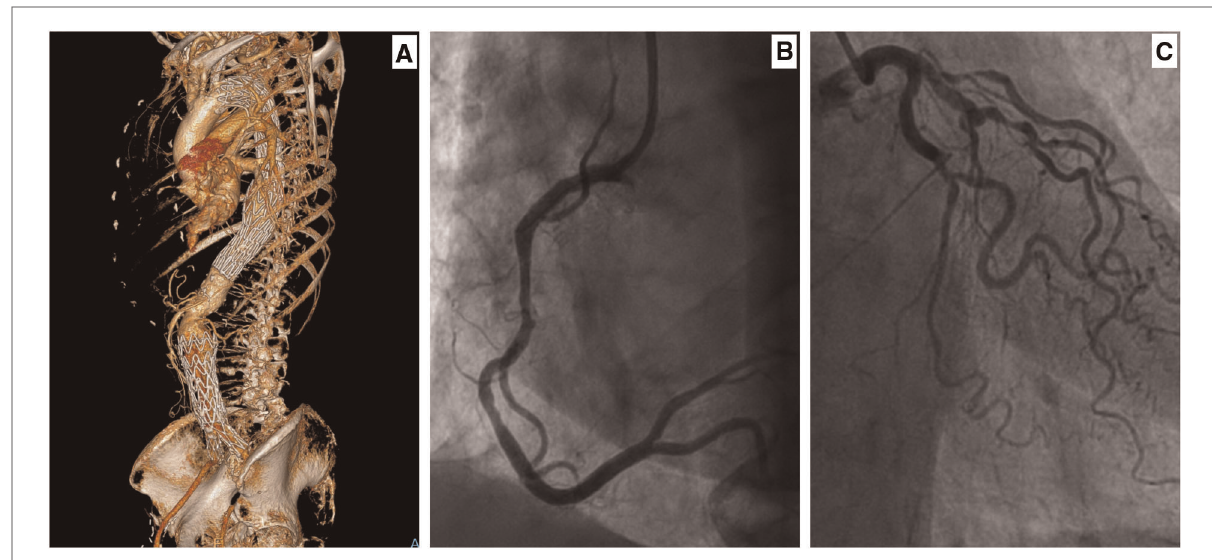
FIGURE 2 A female in her seventies with a saccular aneurysm in the descending thoracic aorta (10). She had thoracic endovascular aortic repair (TEVAR) in 2015 and subsequently underwent endovascular repair of her infrarenal aortic aneurysm in 2018. Her background history included ex-smoker, hypertension, lipid disorder, and right femoral-popliteal percutaneous transluminal angioplasty. ( A ) A 3D-CTA reconstruction, showing thoracic endograft. Following the TEVAR, the patient complained of intermittent chest pain and shortness of breath. A coronary angiogram was performed after her symptoms worsened. ( B ) Coronary angiogram (right main coronary artery) with no evidence of occlusive coronary disease. ( C ) Coronary angiogram (left main coronary artery) with no evidence of occlusive coronary